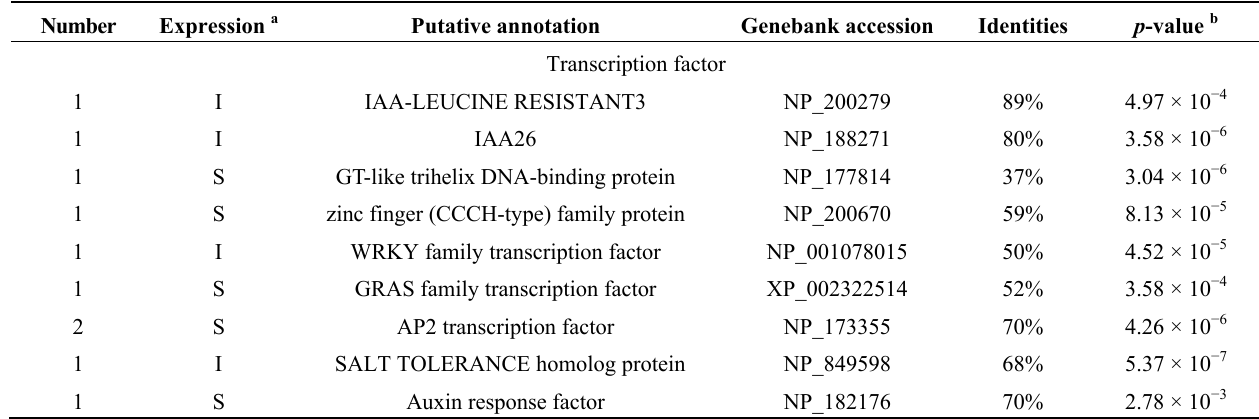
a S means suppression, I means induction; b p -value indicates probability of a gene showing significantly differentially expression between salt-treated samples and untreated samples at significance level of 0.05 using FDR